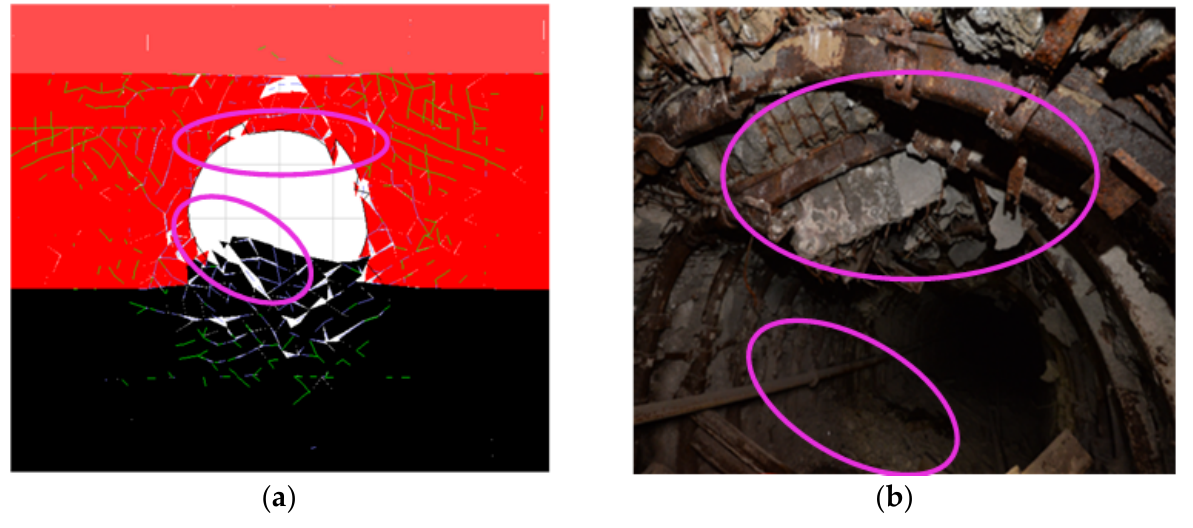
Figure 12. Distribution characteristics of cracks in roadway surrounding rock with the passage of time. ( a ) 1st d; ( b ) 5th d; ( c ) 50th d; ( d ) 200th d; ( e ) 250th d; ( f ) 300th d.